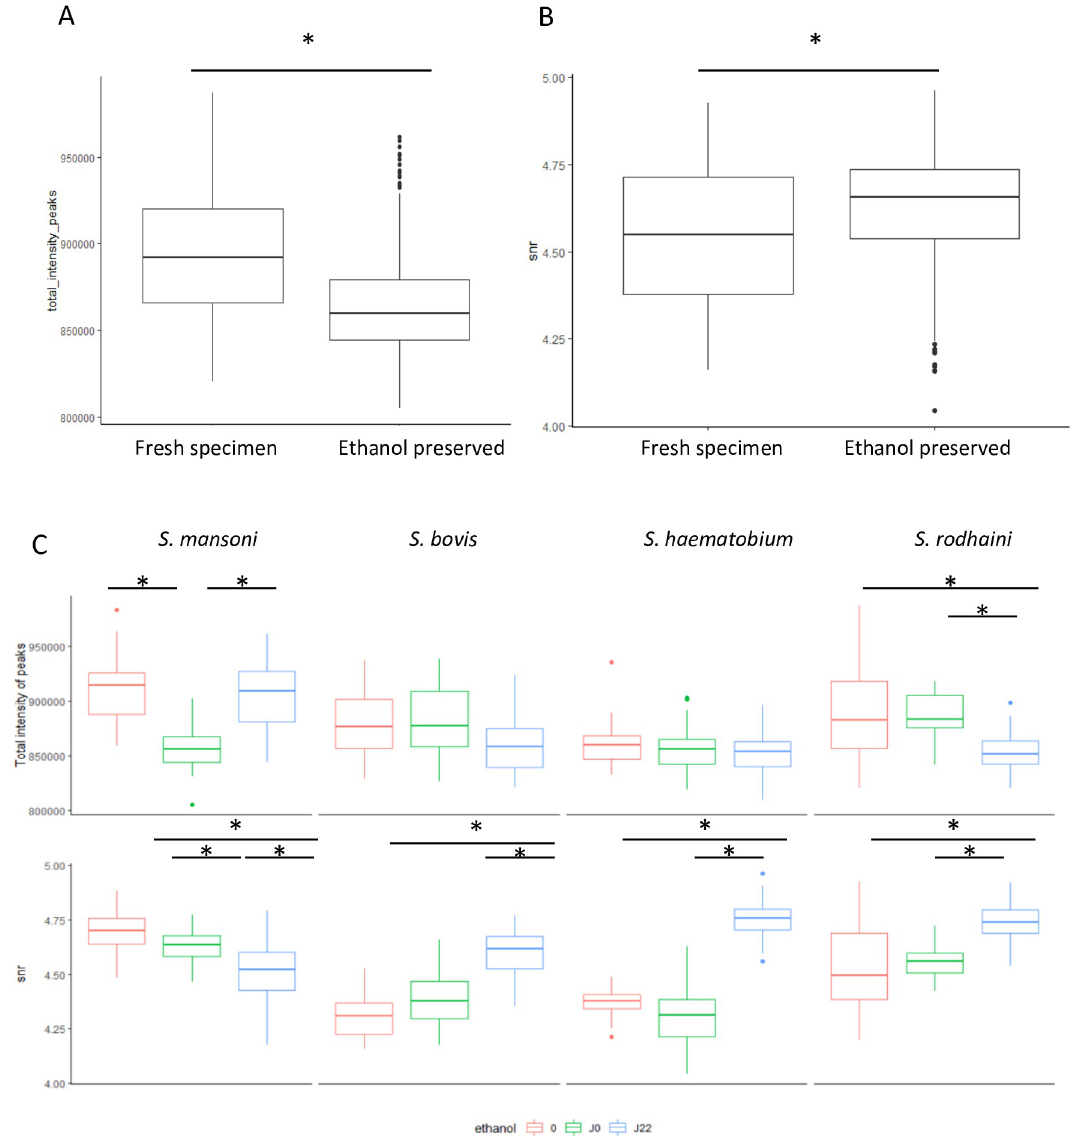
Fig 4. Effect of ethanol fixation on spectral features. A. Boxplot of the sum of peaks intensities in fresh and ethanol preserved specimens. B. Boxplot of the SNR in fresh and ethanol preserved specimens. C. Boxplots of the sum of peaks intensities and SNR in fresh and ethanol preserved specimens according to species. * Statistically significant difference (p adjusted by Bonferroni correction). [64.14–333.1], p < 0.001 Spectrum acquired from S . haematobium cercariae have a lower probability of obtaining LSV1 > 1.7 (odds-ratio of 0.40 CI95% [0.27–0.58]) than those acquired from S . mansoni cercariae (odds-ratio of 4.54, CI95% [3.15, 6.57], p < 0.001). Machine learning for discrimination of the Corsican hybrid Most misidentifications come from confusion between S . haematobium and the Corsican hybrids. Machine learning was thus tested in order to unambiguously distinguish the two spe- cies. A dataset containing spectra (n = 649) from fresh cercariae of pure S . haematobium